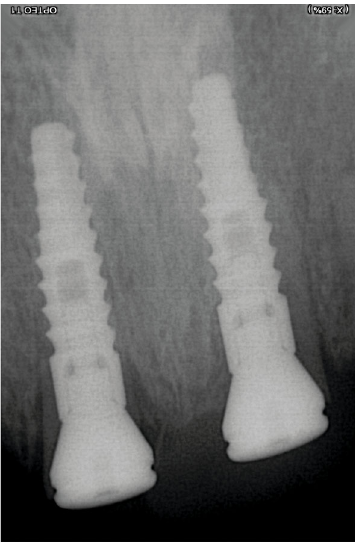
Figure 5: Postoperative periapical X-ray, taken immediately after implant placement.